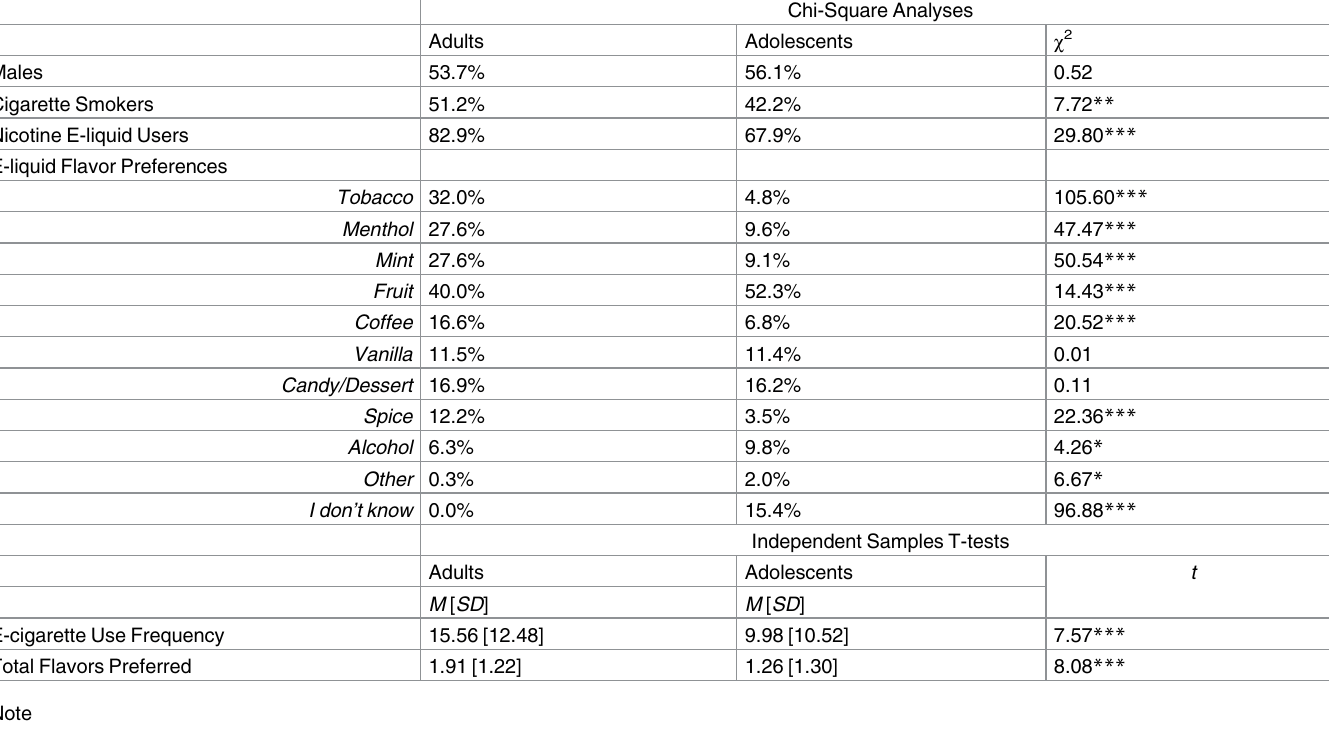
Table 1. Differencesbetween the adult and adolescent samples on central study